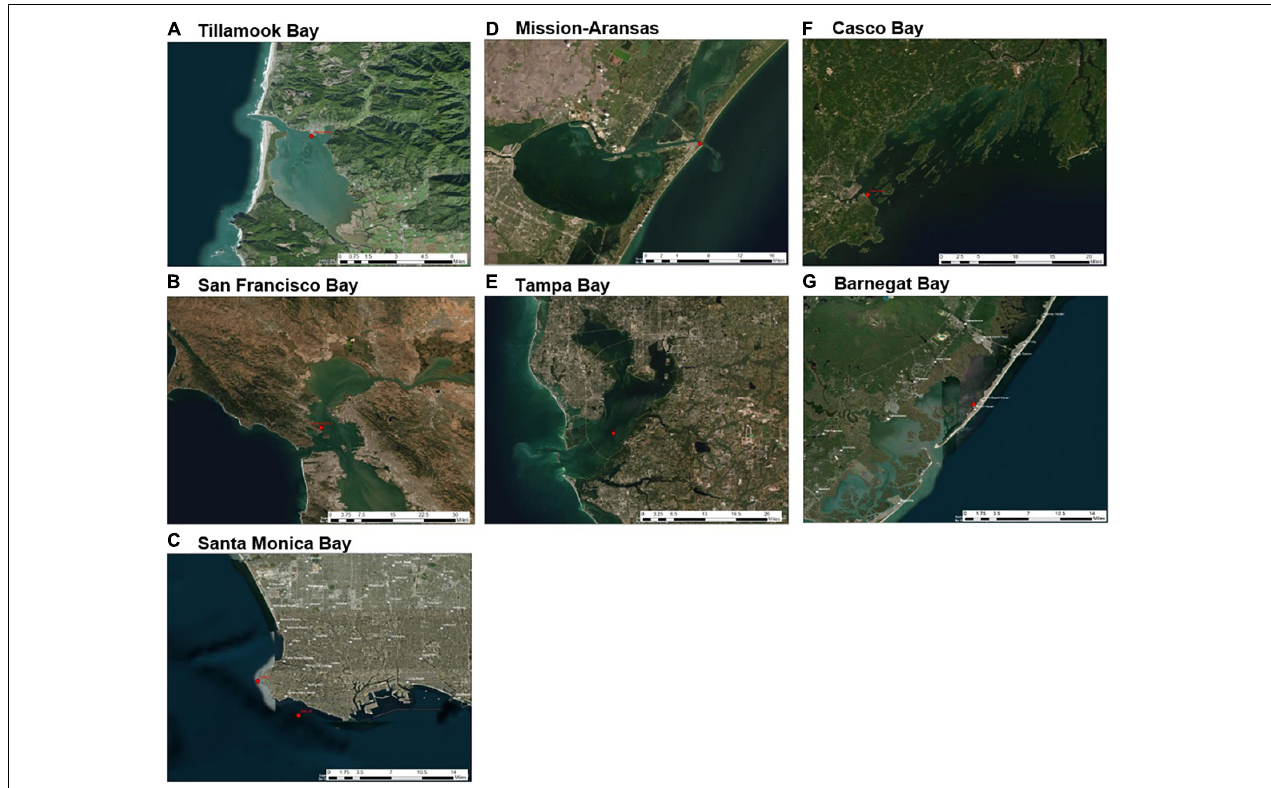
FIGURE 3 | Sensor deployment locations (red dots) in each water body of United States Environmental Protection Agency’s (EPA’s) National Estuary Program (NEP) sites discussed in this study: (A) Tillamook Bay; (B) San Francisco Bay; (C) Santa Monica Bay; (D) Mission-Aransas Estuary; (E) Tampa Bay; (F) Casco Bay; (G) Barnegat Bay. Satellite imagery base layer accessed at https://services.arcgisonline.com/ArcGIS/rest/services/World_Imagery/MapServer. Map image is the intellectual property of ESRI and is used herein under license. Copyright© ESRI 2021 and its licensors. All rights reserved.